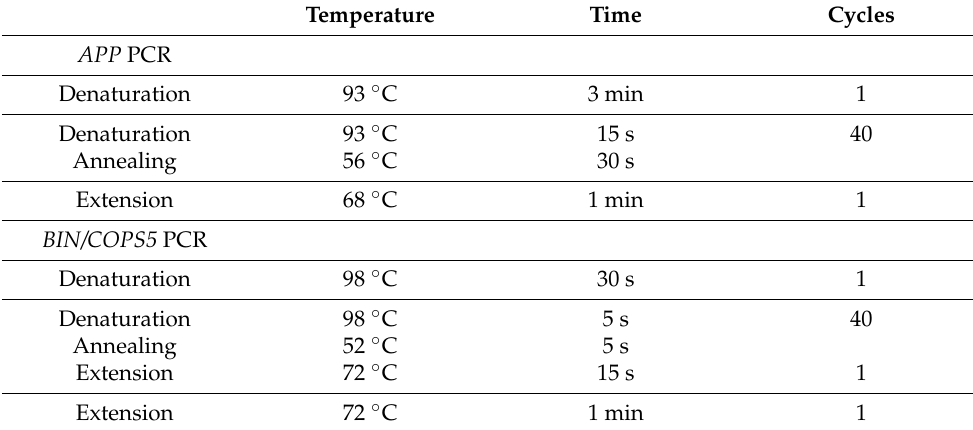
Table 2. PCR conditions for mice genotyping.